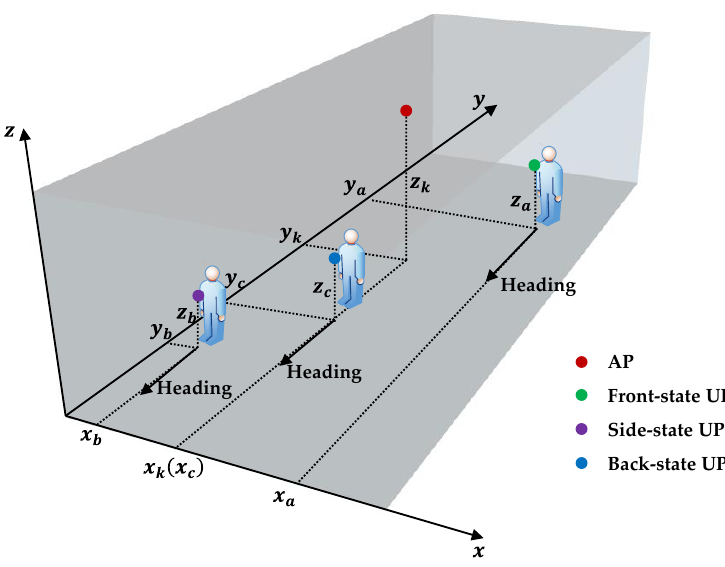
Figure 5. The description of the three shadowing states considered in this work.